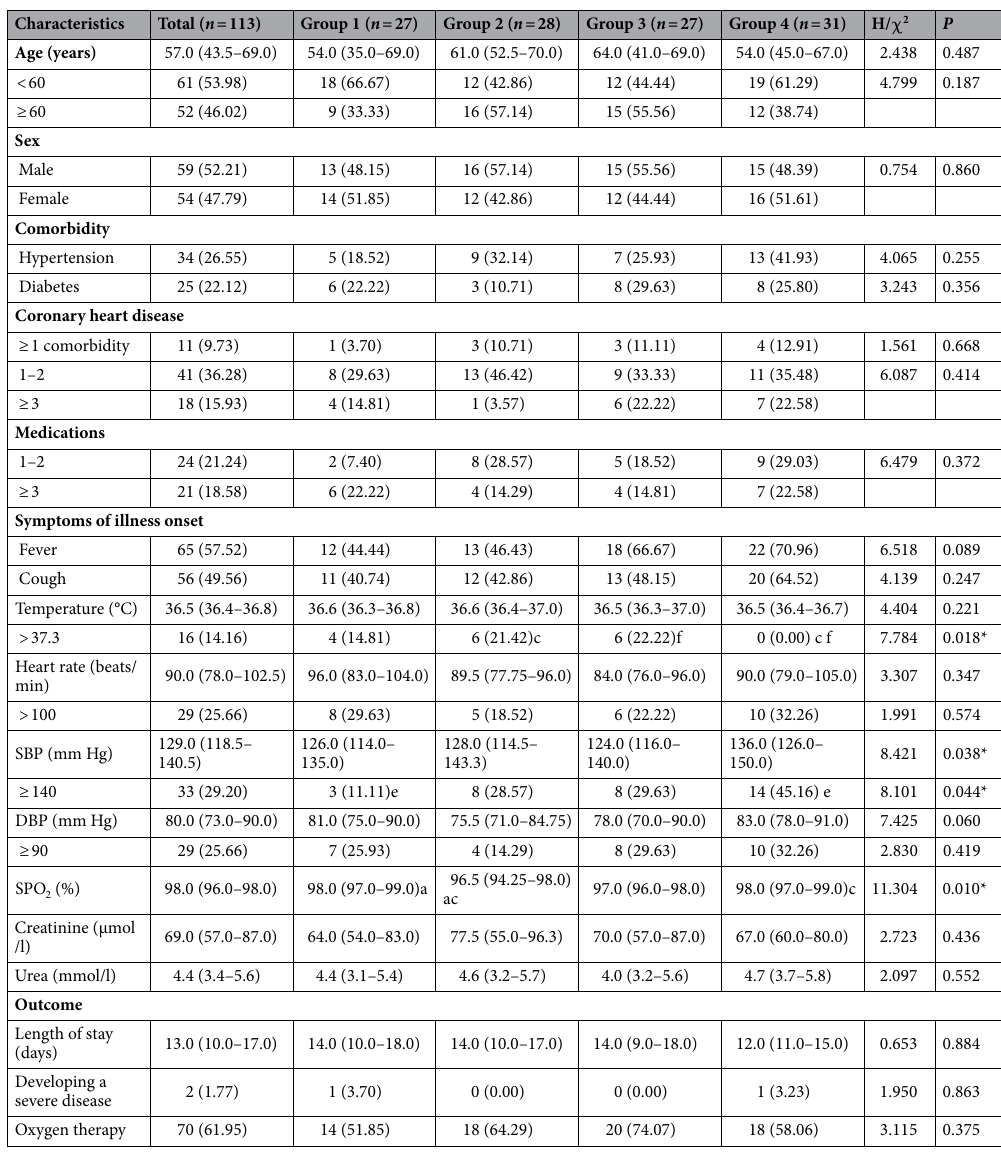
Table 1. Comparisons of demographic and clinical characteristics across the four groups. Data are shown as median (interquartile range) or n (%). P values were calculated by Kruskal–Wallis test, χ 2 test or Fisher’s exact test, as appropriate. SBP, systolic blood pressure; DBP, diastolic blood pressure; SPO 2, pulse oximeter O 2 saturation; * denoted P < 0.05. a denoted P bonferroni < 0.05 between group 1 and group 2. b denoted P bonferroni < 0.05 between group 2 and group 3. c denoted P bonferroni < 0.05 between group 2 and group 4. d denoted P bonferroni < 0.05 between group 1 and group 3. e denoted P bonferroni < 0.05 between group 1 and group 4. f denoted P bonferroni < 0.05 between group 3 and group